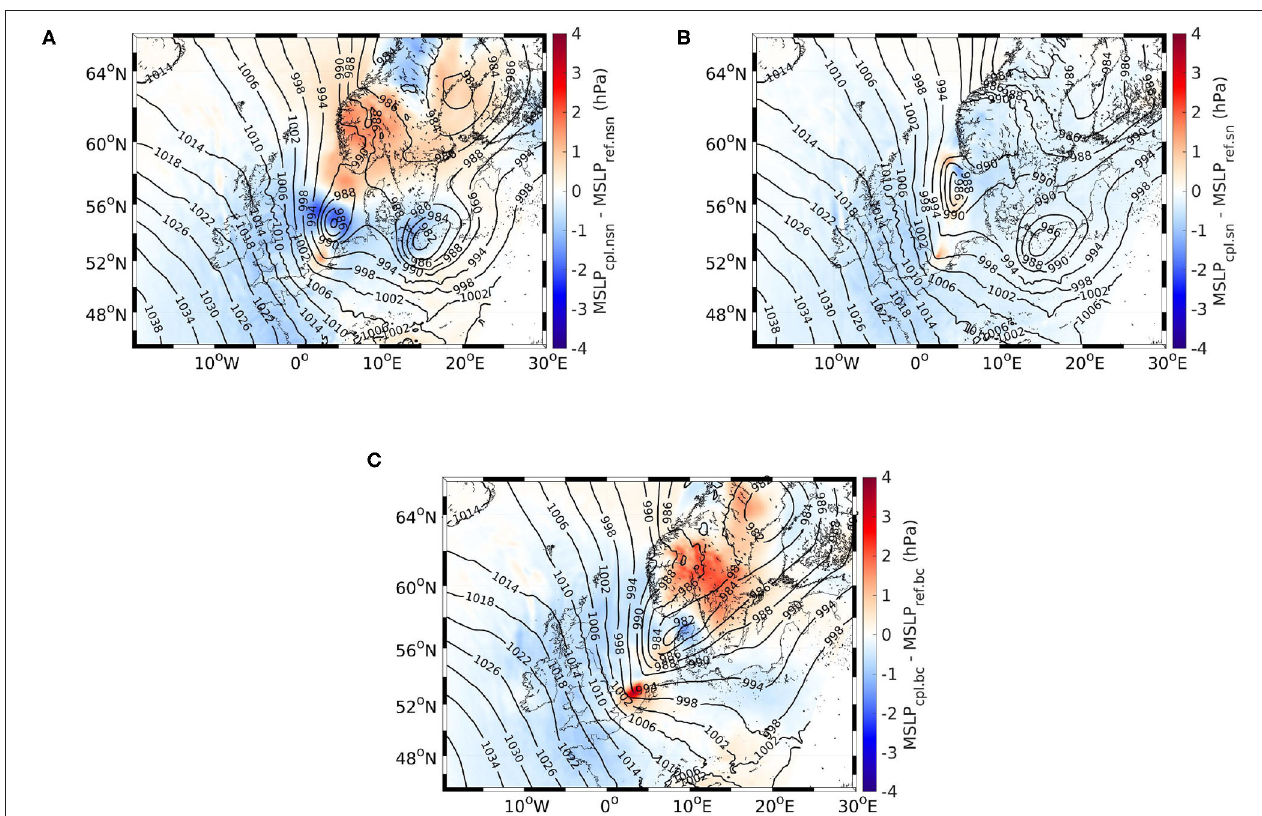
FIGURE 11 | MSLP in the reference simulation on 13 January 2017 at 12 UTC (contour plots) and the differences between the ensemble means of the reference and coupled ensembles both without (A) and with spectral nudging (B) , as well as with the changed boundary conditions (C)